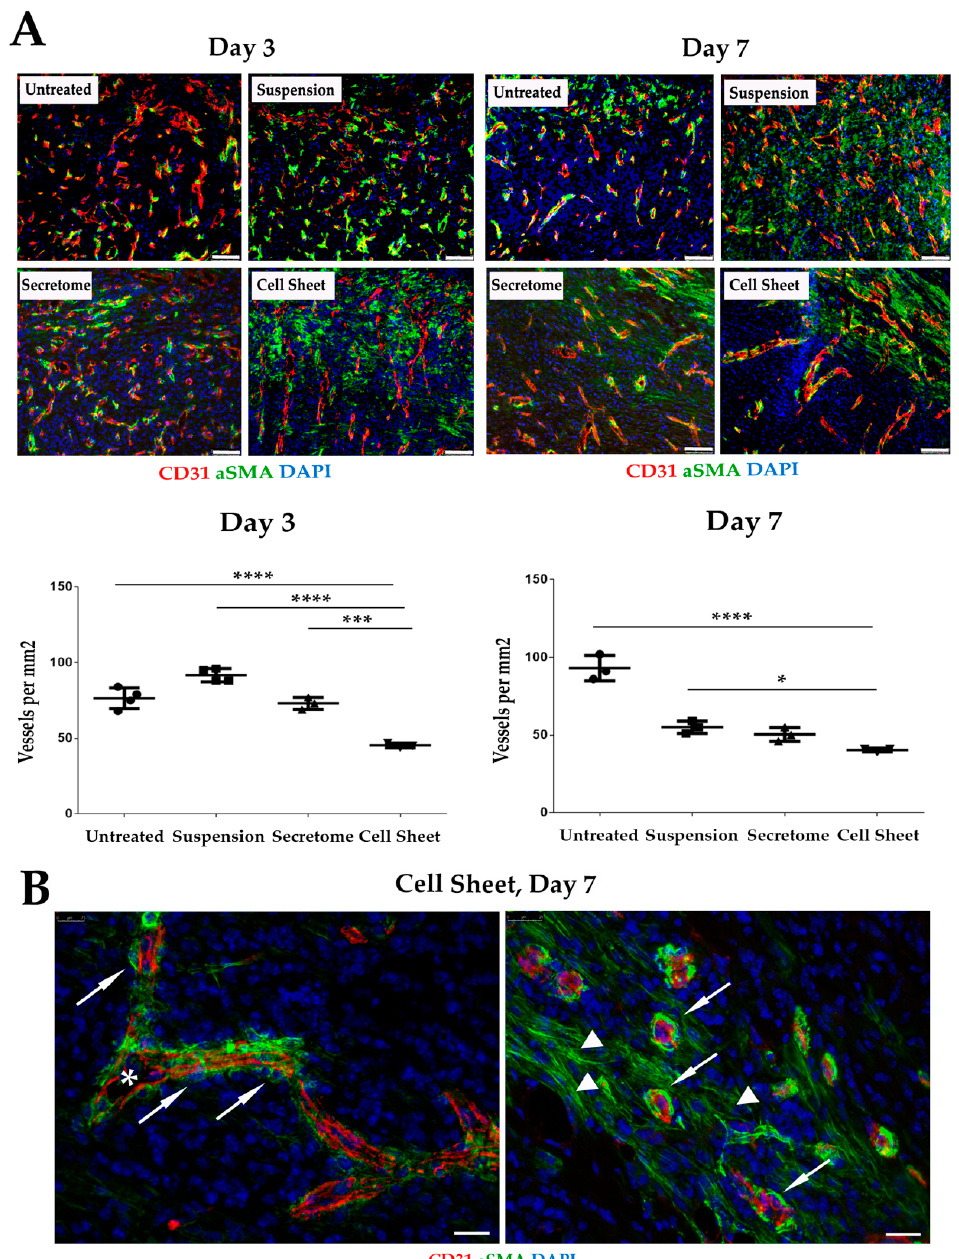
Figure 5. Visualization and quantitative assessment of granulation tissue vascularization in study groups. ( A ) In the “Cell Sheet” group, density of CD31 + blood vessels was reduced (plots at Days 3 and 7). Immunofluorescence, scale bar represents 75 µ m; data present results of manual blood vessels counts; (*— p < 0.05; ***— p < 0.001; ****— p < 0.0001); ( B ) representative images from “Cell Sheet” group showing blood vessels in granulation tissue at Day 7 within healing defect (left image) and on the edge of granulation tissue growth (right image). Arrows indicate α SMA-positive mural cells adjacent to CD31 + blood vessels with lumen; triangles mark α SMA-positive myofibroblasts. Immunofluorescence, scale bar represents 75 µm.